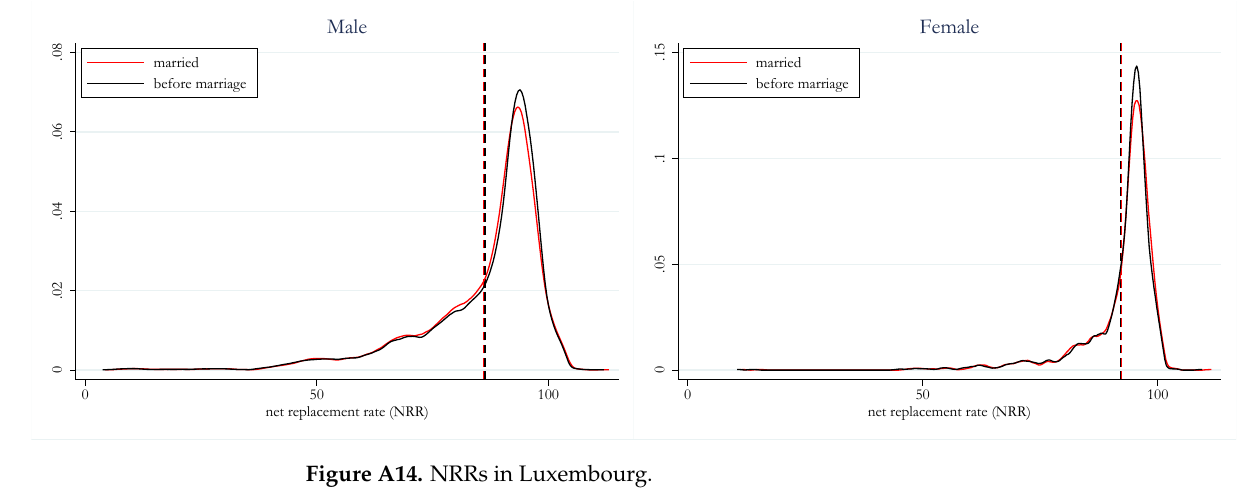
Figure A14. NRRs in Luxembourg.